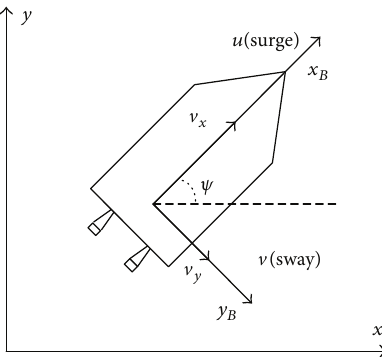
Figure 1: Underactuated surface